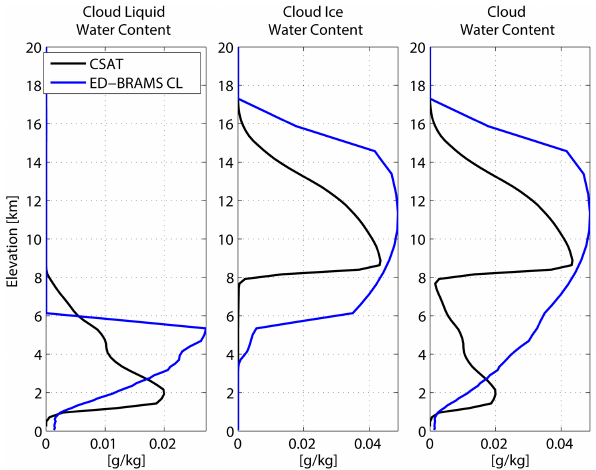
Figure F1. CloudSat climatological water content profiles and model estimated water content profiles for February 2003, 17:00UTC, 3 ◦ N–12 ◦ S and 70–55 ◦